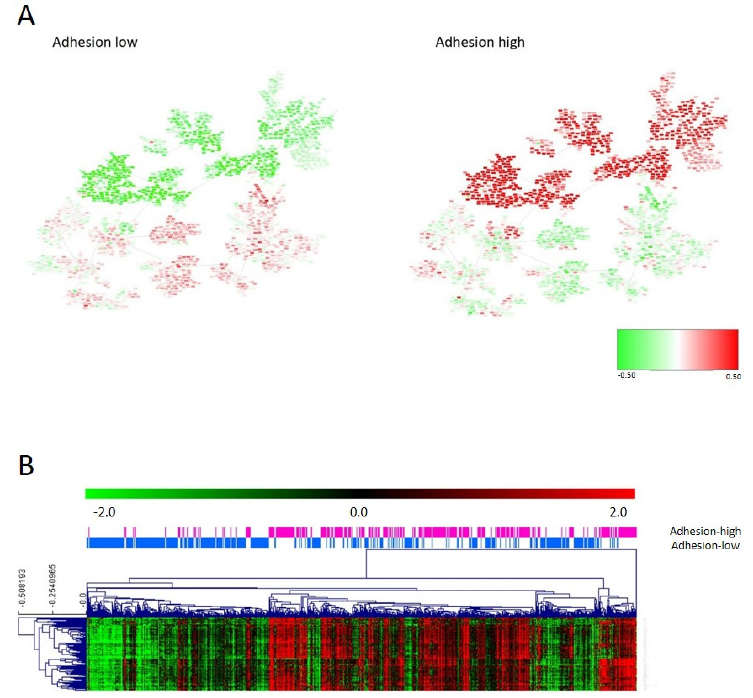
Figure 2. ( A ) Heatmap of the mean gene expression of adhesion groups in the PGM. Red = overex- pressed. Green = underexpressed. ( B ) One hundred differentially expressed genes in the adhesion layer between adhesion 1 and 2 groups identified by SAM.